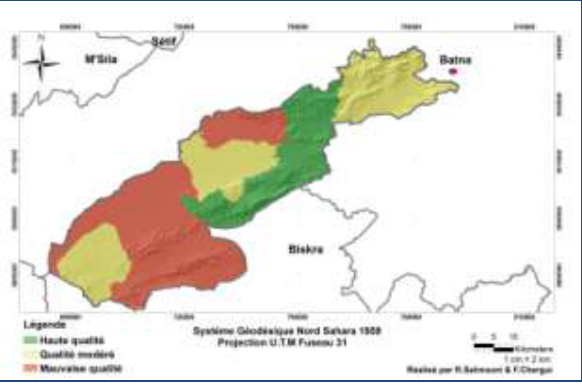
Figure 5. Management quality map of southern massif Belezma